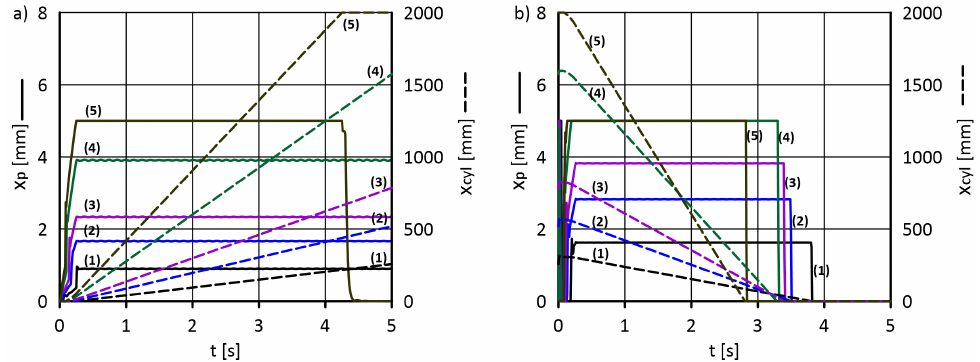
Figure 11. Check valve gap width x p ( t ) and hydraulic actuator displacement c cyl ( t ) for the nominal stiffness k spr = k nom = 41.0 N mm − 1 ; ( a ) A-B flow direction, ( b ) B-A flow direction.